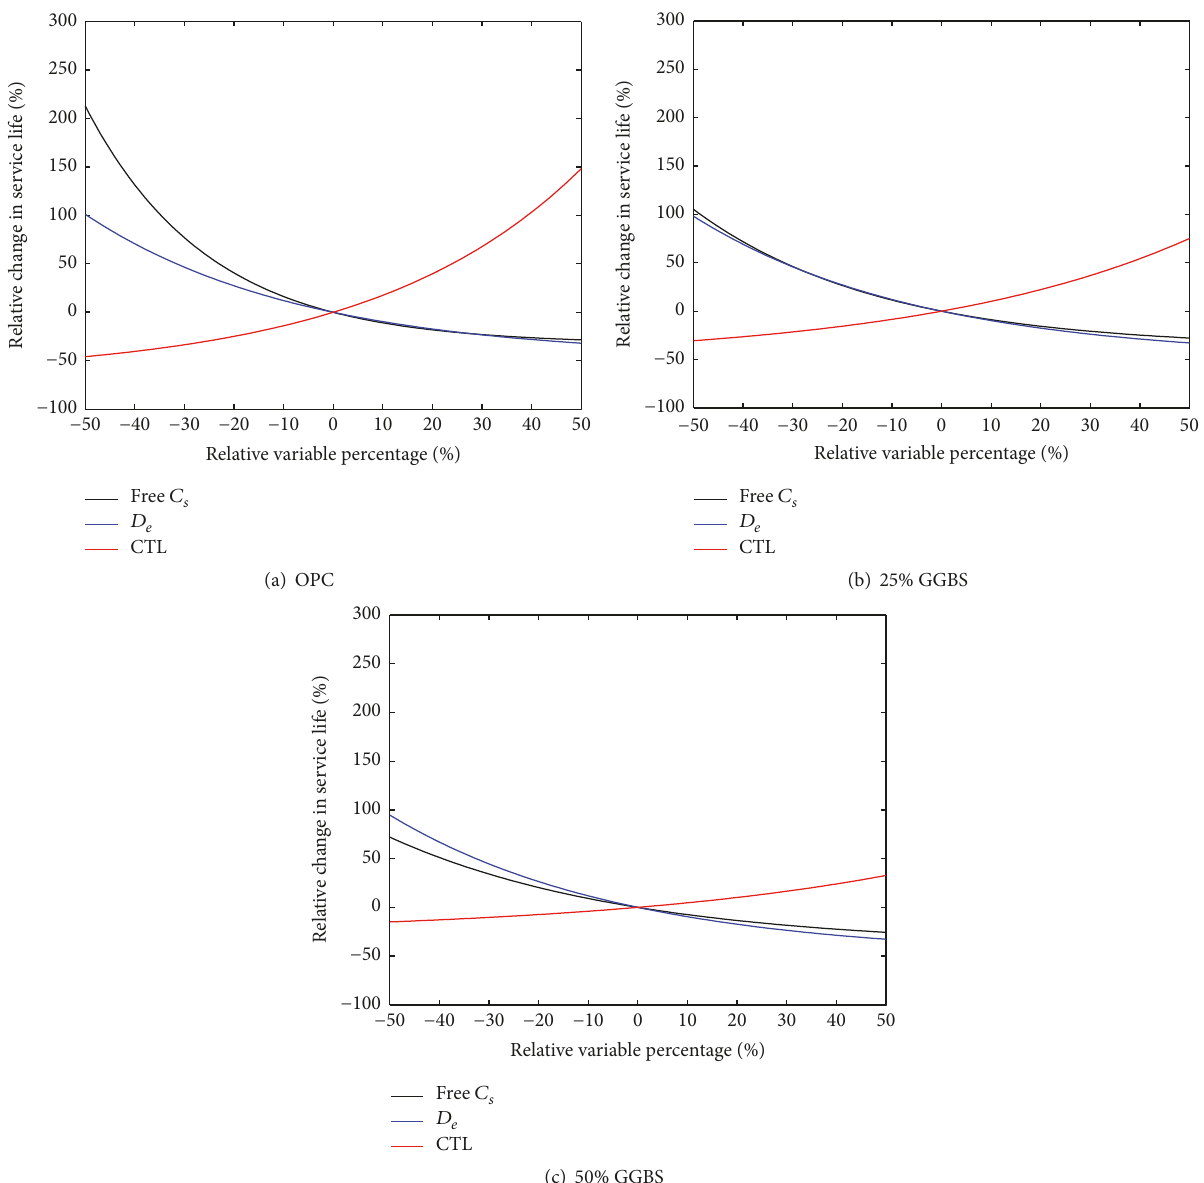
Figure 7: Sensitivity of GGBS replacement ratio to service life estimation with percentage change of